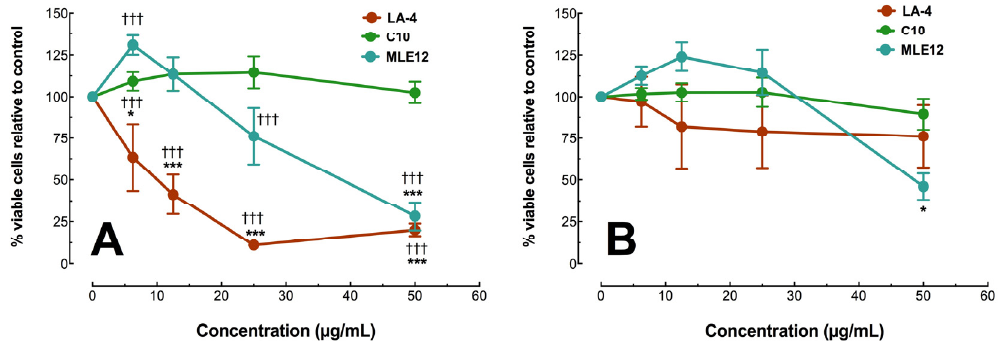
Figure 6. Toxicity of citrate-stabilized Ag nanospheres in three murine epithelial cell models using the MTS assay 24 h post particle exposure. ( A ) Percent viable cells with 100% confluent murine epithelial Type II cells exposed to 20 nm Ag nanospheres; ( B ) Percent viable cells with 100% confluent murine epithelial Type II cells exposed to 110 nm Ag nanospheres. All data expressed as mean ± SEM % viable cells relative to no particle (0 µg/mL) condition. Asterisks indicate significance at *** p < 0.001, or * p < 0.05 compared to 0 µg/mL control condition by post hoc mean comparisons. Daggers indicate significance at ††† p < 0.001 compared to the other cell lines at a specific